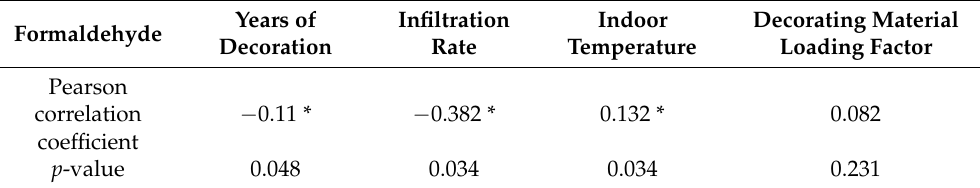
Table 6. Correlation analysis.